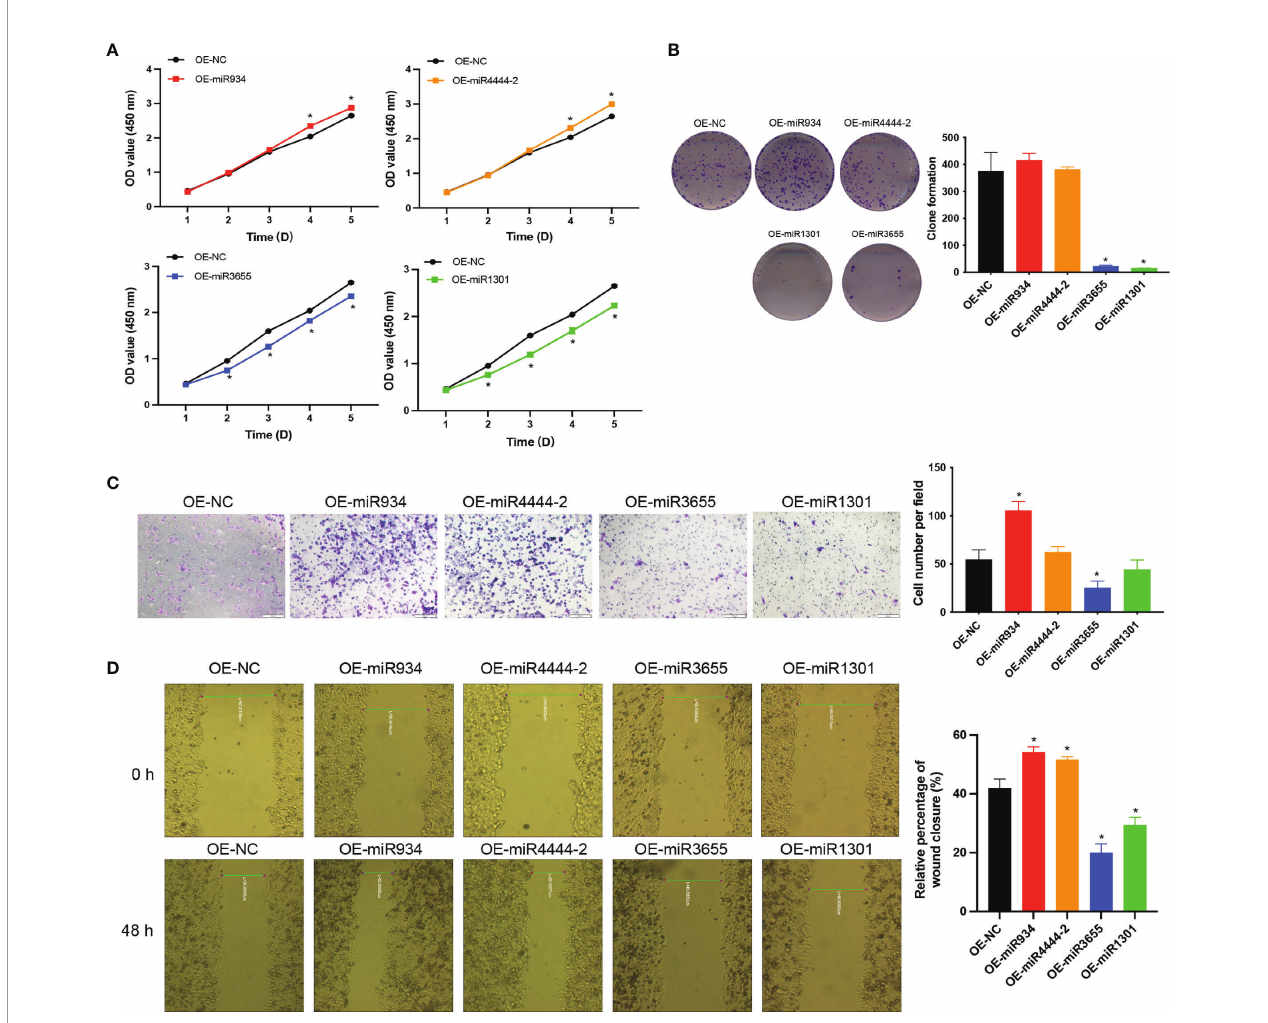
FIGURE 10 | The effects of miR-934, miR-4444-2, miR-1301 and miR-3655 on proliferation and migration of PC cells. (A, B) Overexpressed of miR-934 and miR- 4444-2 observably promoted the proliferation ability in PC cells compared with the NC group (Overexpression of miR-1301 and miR-3655 has the opposite effect on cells). (C, D) Overexpressed of miR-934 and miR-4444-2 could signi fi cantly increase the migration of PC cells (Overexpression of miR-1301 and miR-3655 has the opposite effect on cells) (t test, *P <